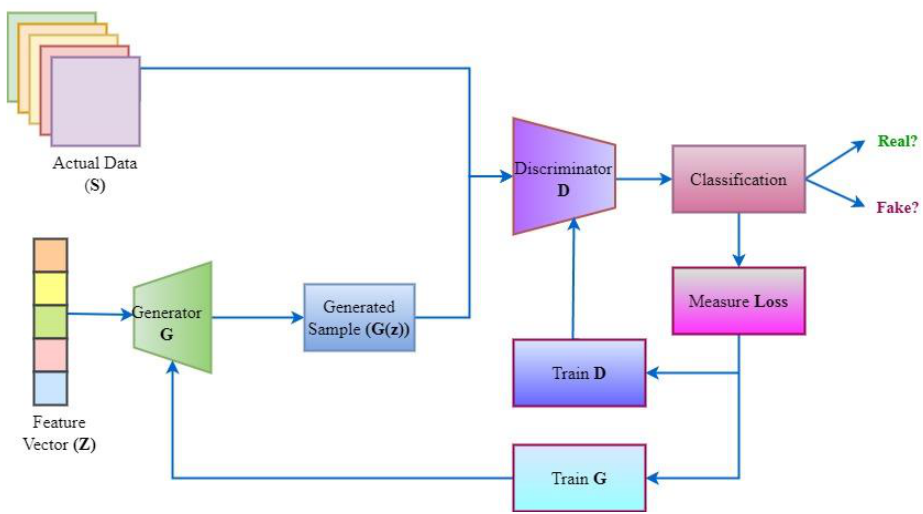
Figure 1. The architecture of conditional generative adversarial network.